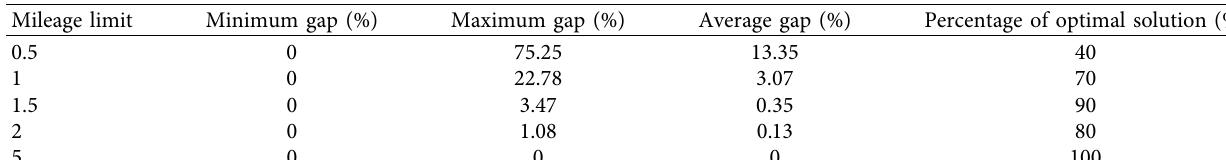
Table 2: Infuence of the mileage limit on the accuracy of the greedy algorithm.